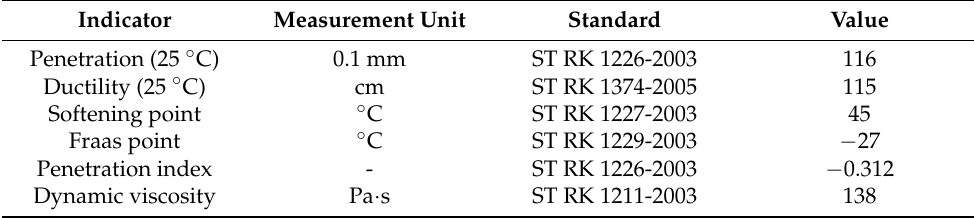
Table 1. Main standard indicators of the virgin